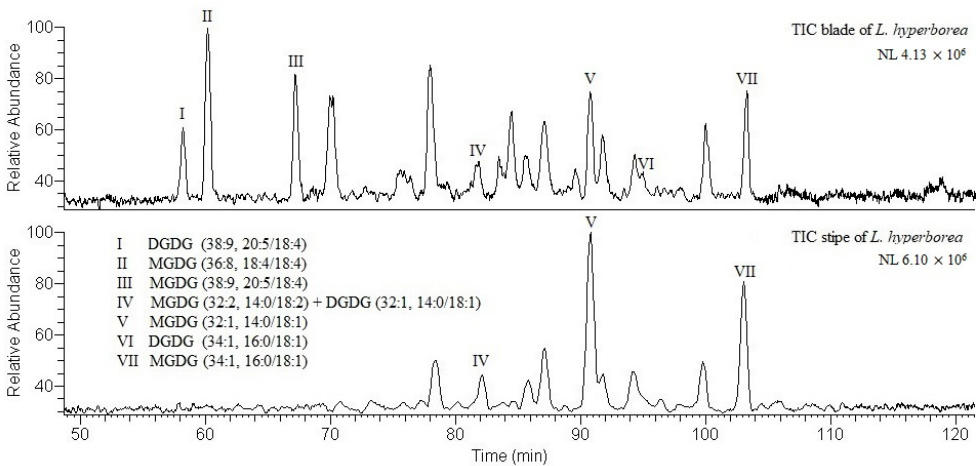
Figure 2. Total ion chromatogram (TIC) of blade ( top ) and stipe ( bottom ) of Laminaria hyperborea . The molecular species indicated after the carbon-to-double-bond-equivalent ratio (C:DBE) was the most abundant species for that C:DBE. MGDG: monogalactosyldiacylglycerol, DGDG: digalactosyldiacylglycerol, NL: normalization level (base peak intensity).